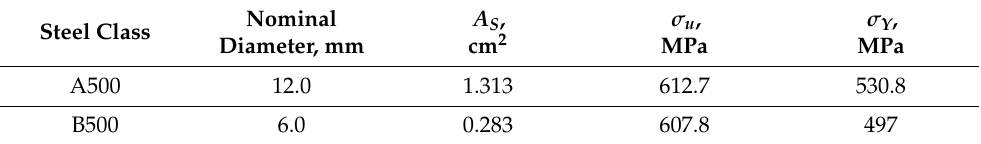
Table 2. Strength and deformation characteristics of steel bar reinforcement used for short columns.